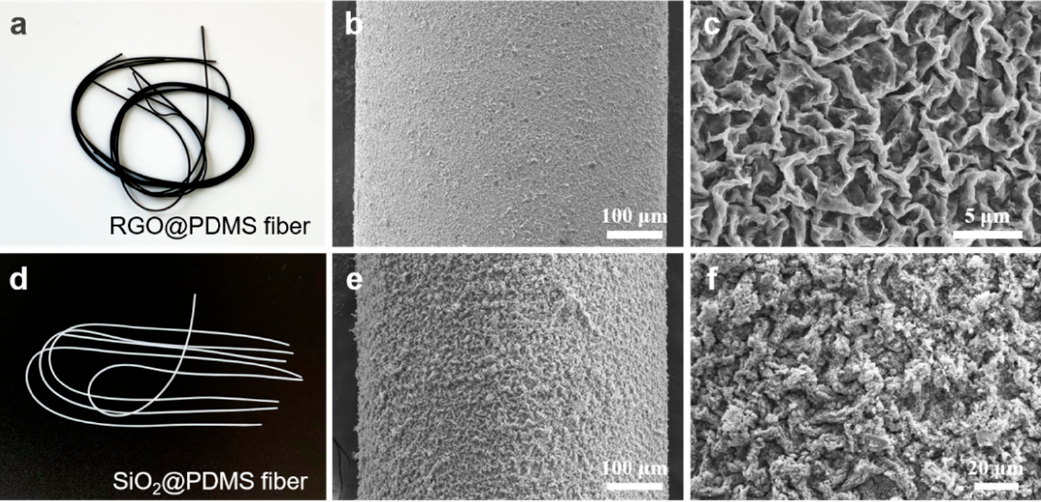
Figure 5. ( a ) Photograph of RGO@PDMS fibers. ( b , c ) Surface morphologies of RGO@PDMS fiber. ( d ) Photograph of SiO 2 @PDMS fibers. ( e , f ) Surface morphologies of SiO 2 @PDMS fiber.